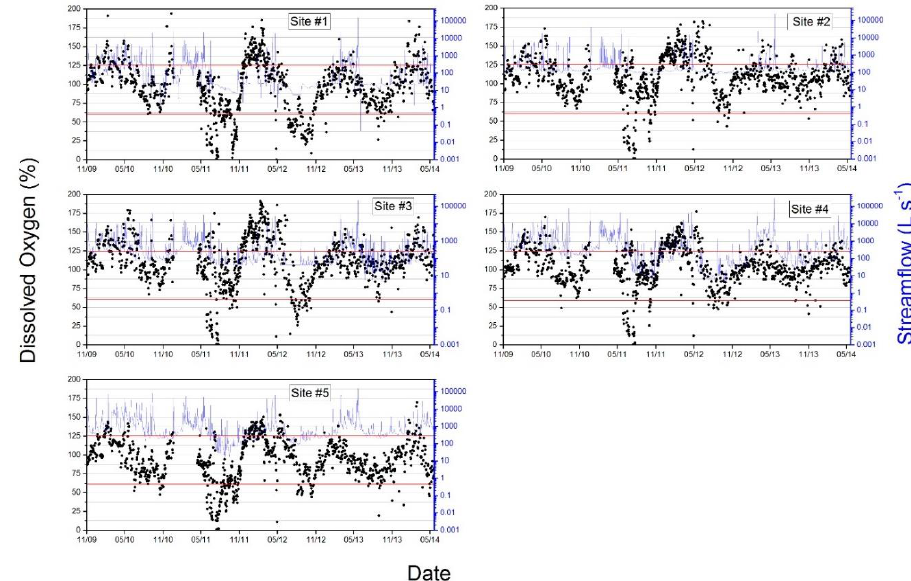
Figure 6. Dissolved oxygen (% of saturation) and streamflow (L s − 1 ) at each gauging site ( n = 5) during study period (October 2010–May 2014) in Hinkson Creek Watershed, MO, USA. Red lines depict minimum and maximum thresholds established by Missouri Department of Natural